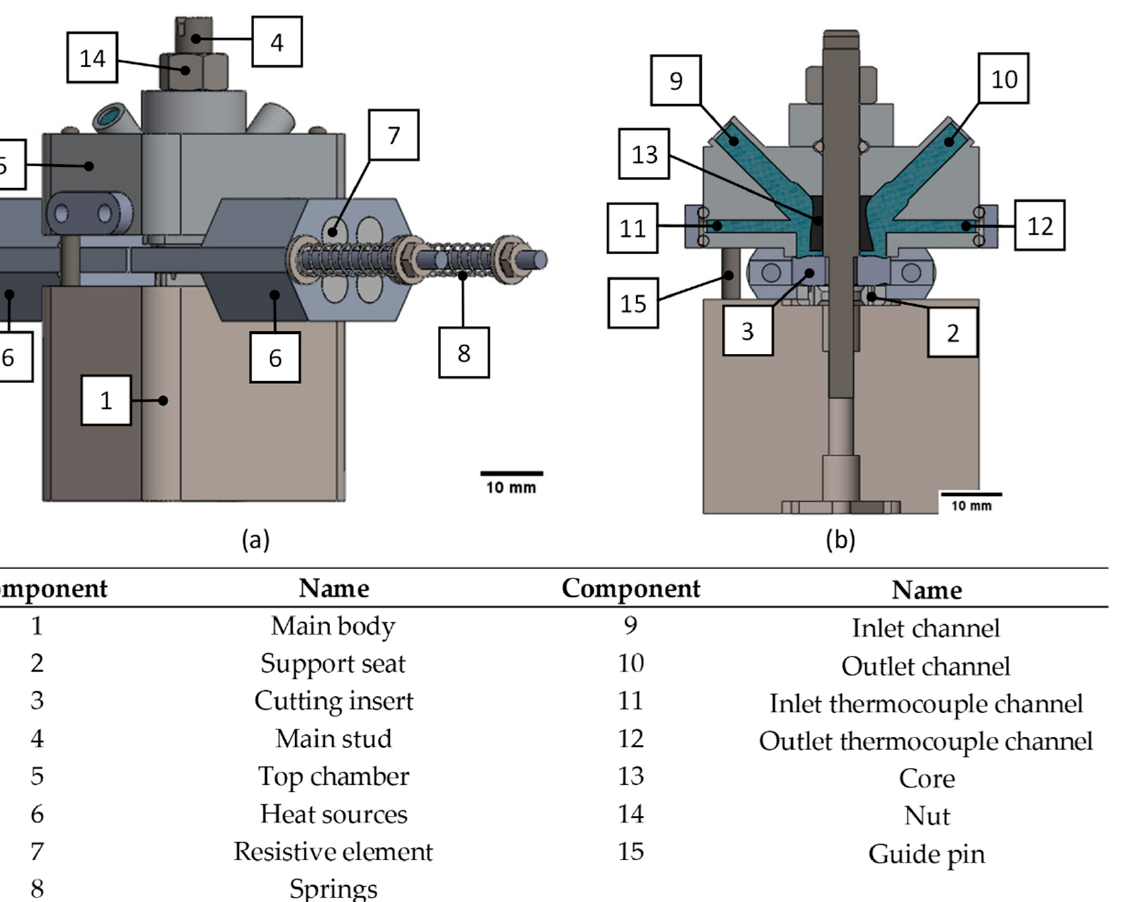
Figure 1. CAD model with components identification: ( a ) full assembly; ( b ) middle cross-section.